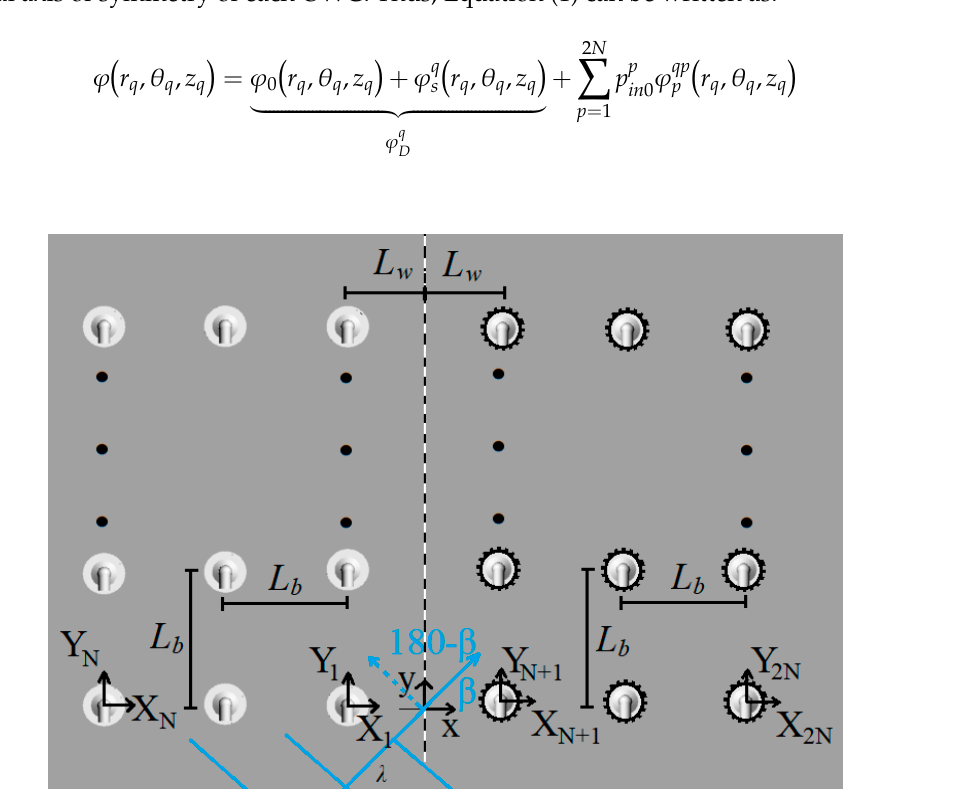
Figure 2. 2D plane representation of a breakwater-OWC system using the method of images. The image devices are denoted dashed.